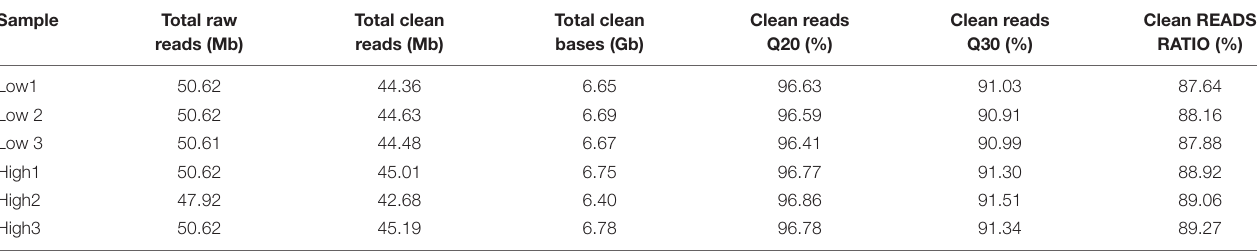
TABLE 1 | Overview of the RNA-sequencing reads generated from each sample.